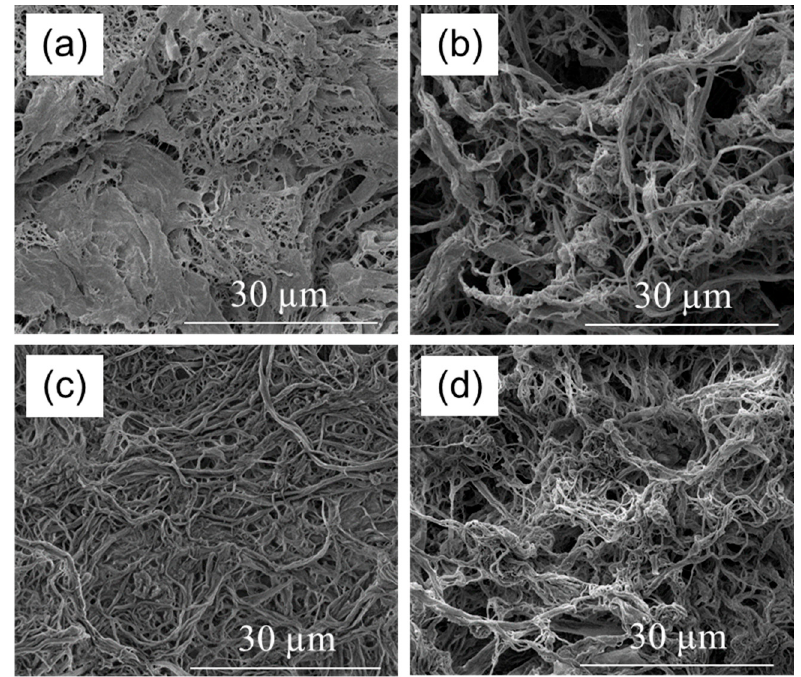
Figure 4. Scanning electron microscopy (SEM) images of different NFC variants dried from n -hexane: ( a ) unmodified NFC; ( b ) blank NFC sample, solvent-exchanged to propylene carbonate; ( c ) 24 h (2-dodecen-1-yl)succinic anhydride-treated NFC; and ( d ) 24 h acetic anhydride-treated NFC.